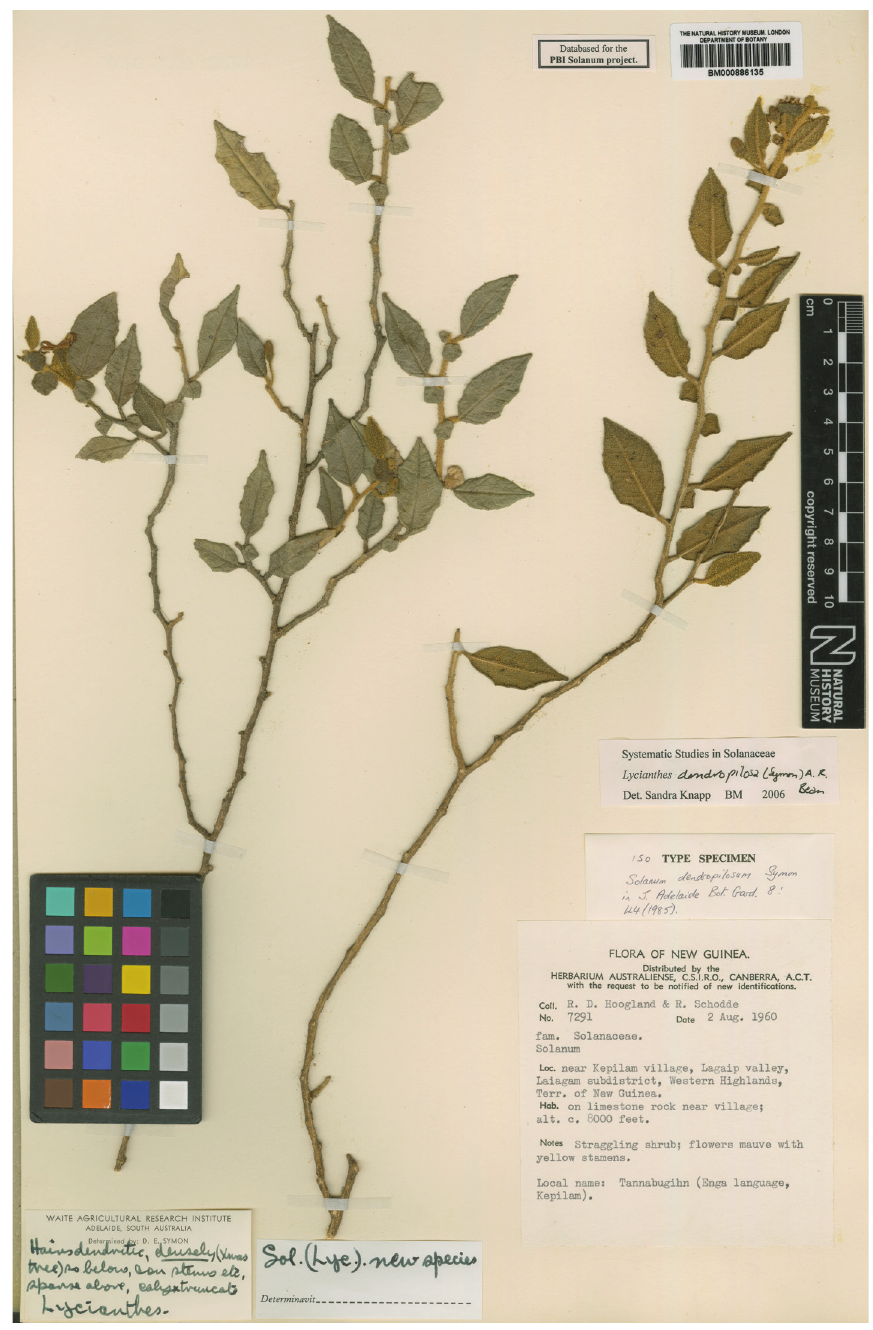
Figure 20. Lycianthes dendropilosa herbarium specimen. Papua New Guinea. Western Highlands: Hoog- land & Schodde 7291 (isotype of S. dendropilosum , BM000886135). Courtesy of the Trustees of the Natural History Museum, London, reproduced with